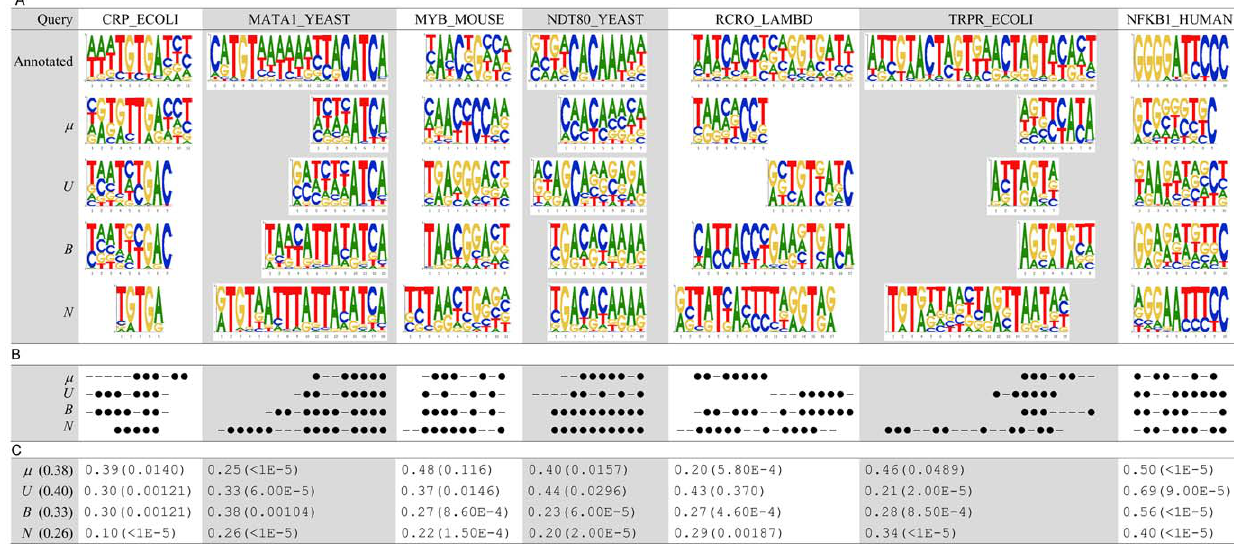
Figure 3. Predictions using different complexes. m : the proposed method. U : the second synthetic complex that eliminates the second type of structural variation. B : the third synthetic complex that eliminates the second and third types of structural variation. N : native complexes. (A) PWMs. N ’ if its most favorable base type was correctly predicted, or marked as ‘–’ otherwise. (C) Y -scores and the corresponding (B) A position is marked as ‘ p-values. The value within the parentheses of the first column indicates the average Y -score.